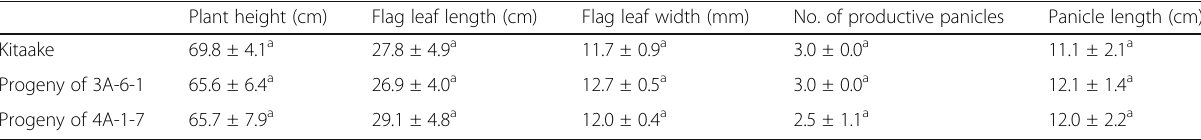
Table 2 Analysis of the agronomic traits of T 3 mutant lines